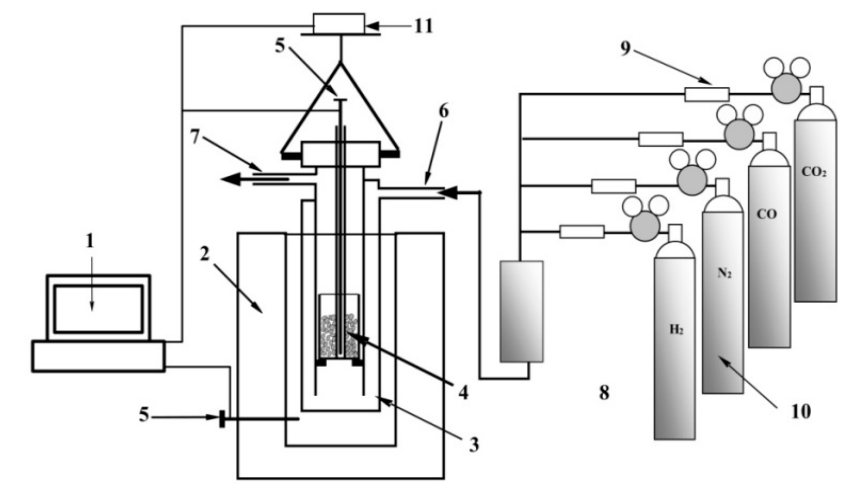
Figure 1. Schematics of experimental apparatus for reduction experiments.